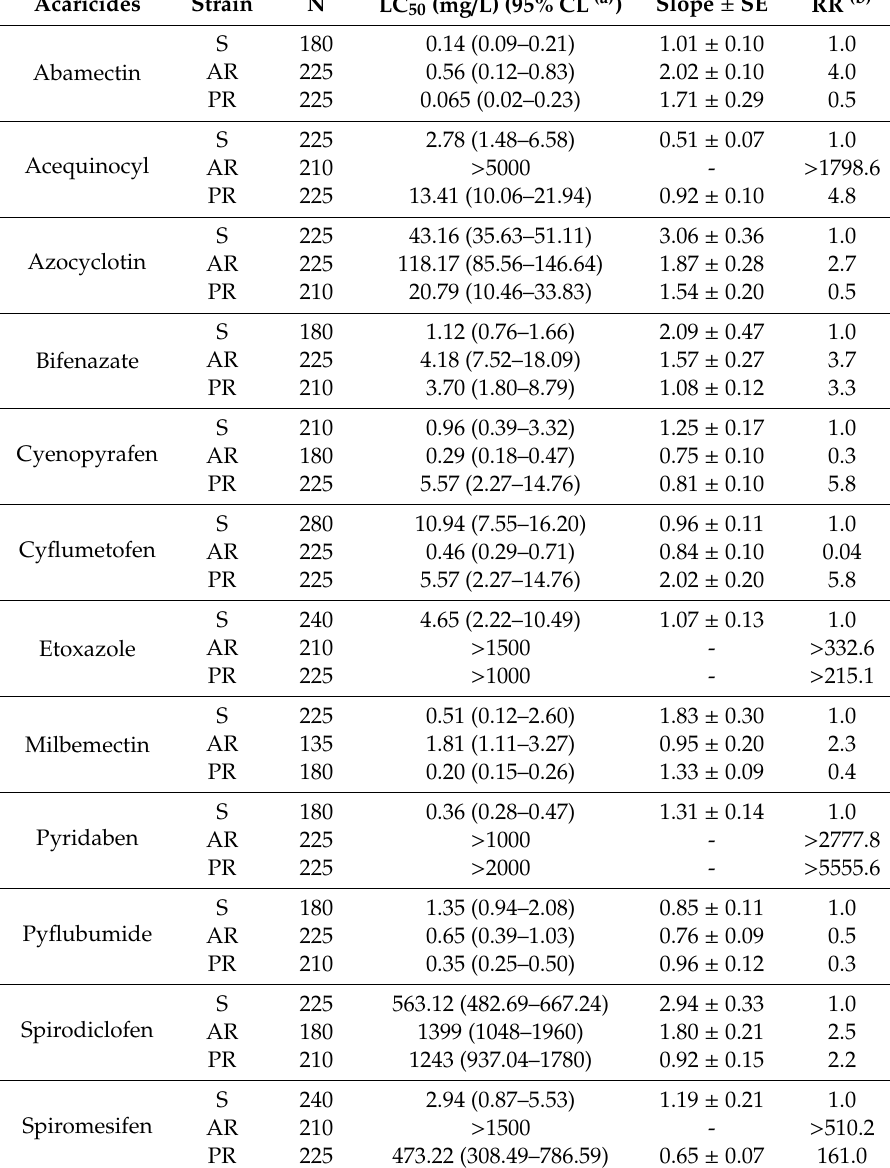
Table 2. Susceptibility to acaricides in the S, AR and PR strains of Tetranychus urticae